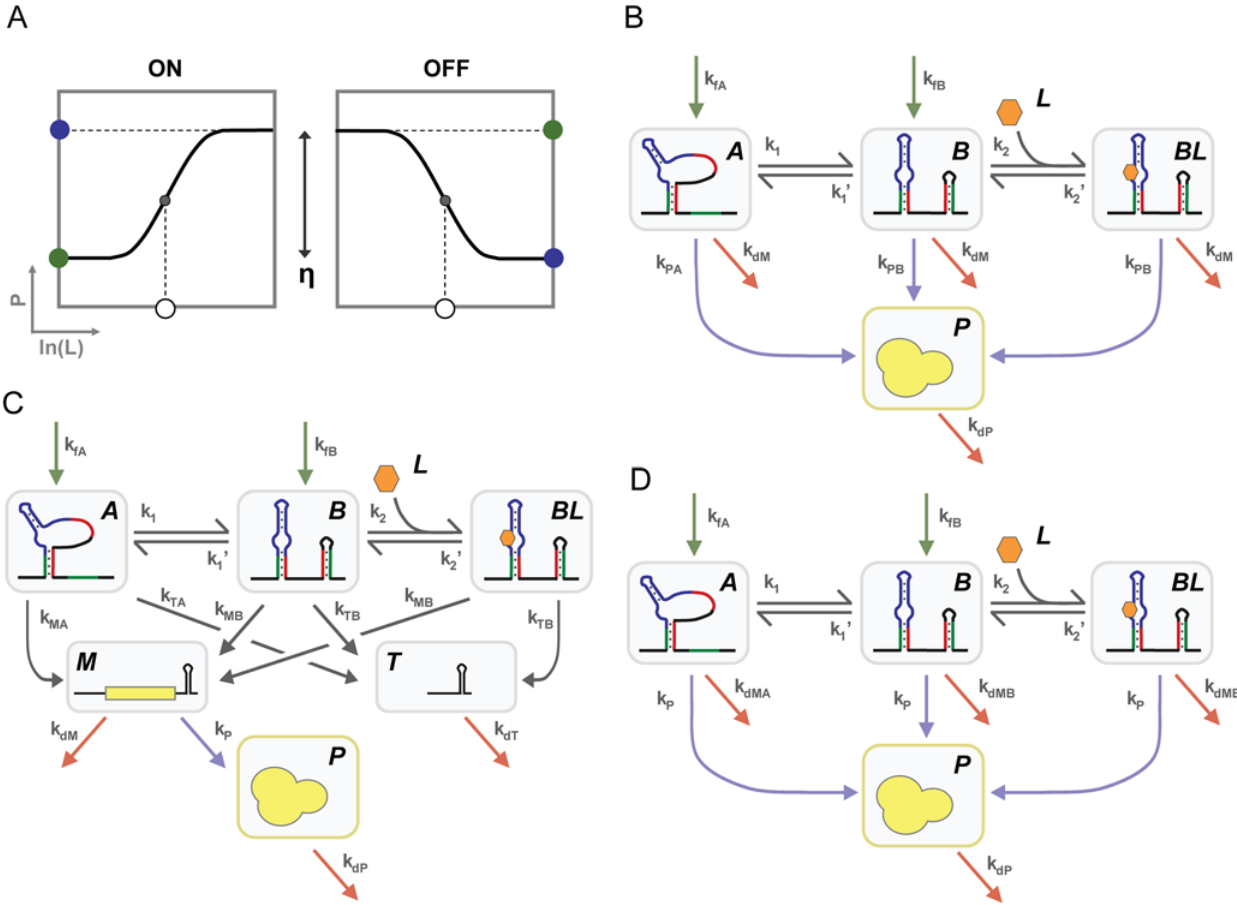
Figure 1. Kinetic models for riboswitches functioning through three distinct regulatory mechanisms. (A) General response curve relating ligand concentration (L) and regulated protein levels (P) for both ON and OFF behavior. Descriptors important in evaluating riboswitch performance are indicated: dynamic range ( g ), EC 50 ( # ), basal protein levels (green N ), and ligand-saturating protein levels (blue N ). Gene regulatory mechanisms include (B) translational repression, (C) transcriptional termination, and (D) mRNA destabilization. All riboswitches can reversibly switch between conformations A and B that display different regulatory activities or different rates of degradation. Conformation B contains a formed aptamer that can reversibly bind ligand. Models assume negligible ligand binding during transcription. Green arrows designate mRNA synthesis with biased transcriptional folding, red arrows designate species degradation, and blue arrows designate translation that is proportional to mRNA levels. Under transcriptional termination (C), riboswitches effectively choose between termination to form a truncated product (T) and extension to form the full-length mRNA (M). To ensure both conformations make the decision with the same frequency, we designated a rate constant k M equal to the sum of the rate constants for extension and termination for either conformation (k M =k MA + k TA =k MB + k TB